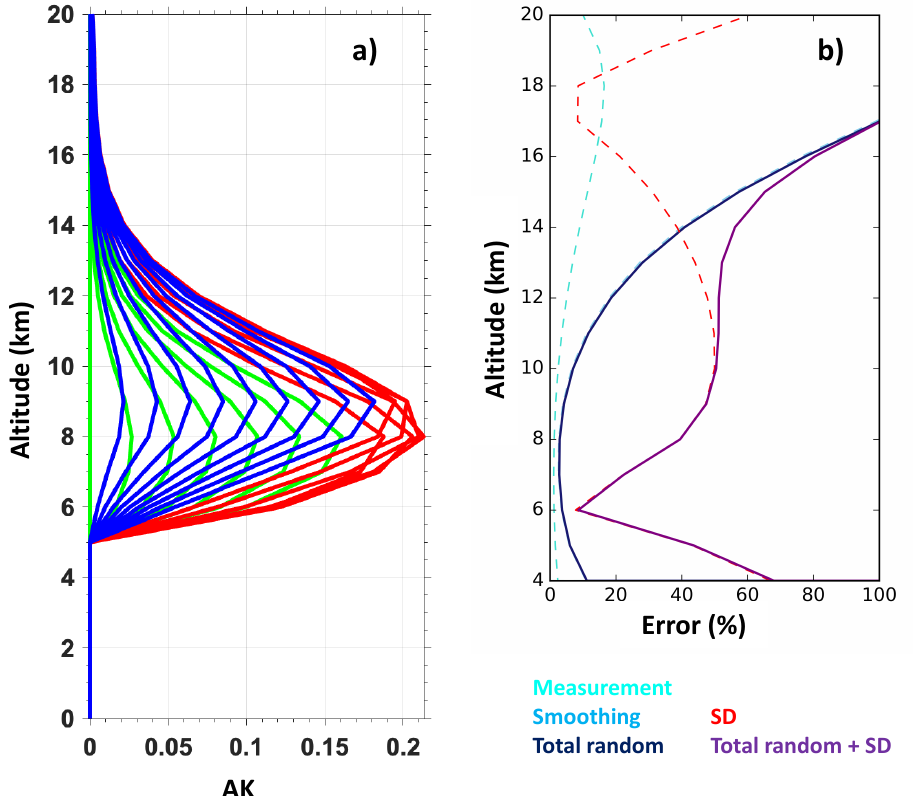
Figure 4. ( a ) Averaging kernels (AK) for a selected pixel into the eastern plume of Figure 3. Green are AK for surface-6 km, red for 7–12 km and blue 13–20 km; ( b ) vertical profile of the percent retrieval error of SA number density retrieval due to radiometric measurement noise (cyan profile), vertical smoothing (sky blue), and size distribution assumptions (red). Total random errors (blue) and total error (random plus size distribution, purple) are also